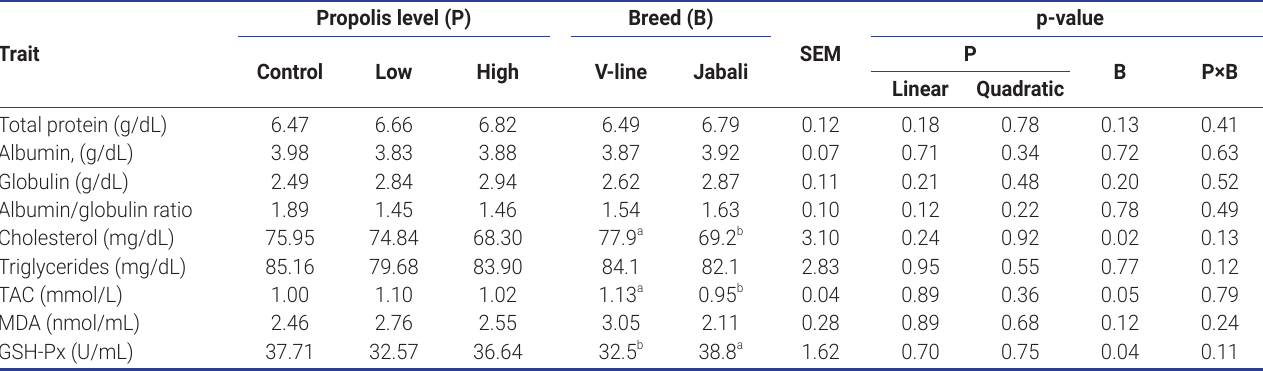
Table 3. Effect of propolis level and breed on blood biochemistry and antioxidant profile in rabbits